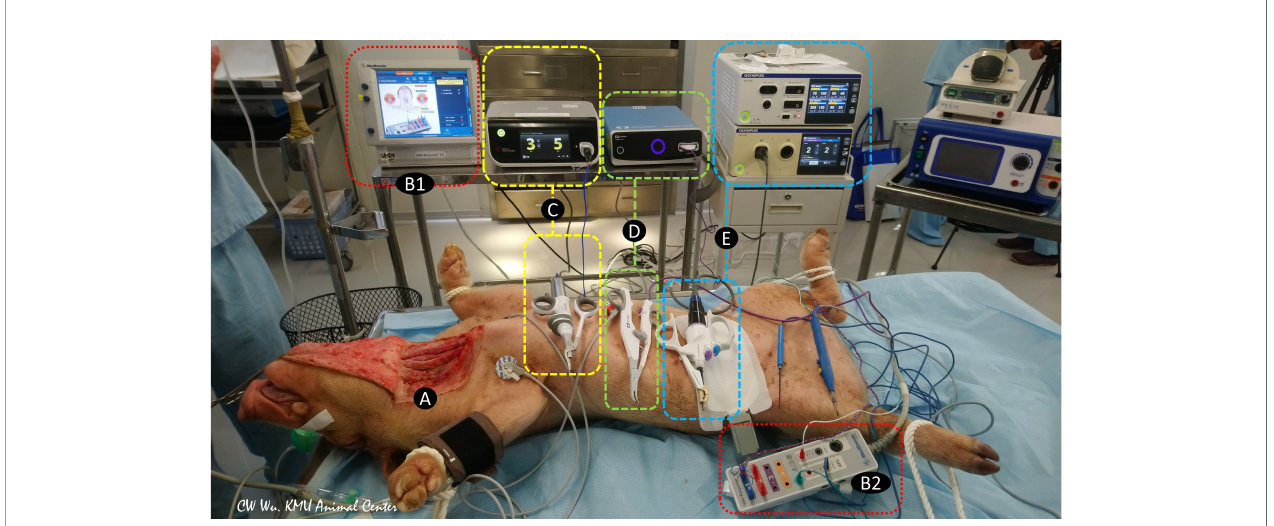
FIGURE 1 | Animal models of continuous intraoperative neuromonitoring (cIONM) provide an objective platform for optimizing the safety parameters for various energy-based devices used for hemostasis and dissection near the recurrent laryngeal nerve (RLN) during thyroid surgery. (A) Preparation of porcine animal model by transverse incision and fl ap formation in neck skin. (B1) IONM monitoring system used for recording, monitoring, and analyzing real-time changes in laryngeal EMG. (B2) IONM interface box for connecting recording, stimulation, and ground electrodes. (C) Ultrasonic energy based device and